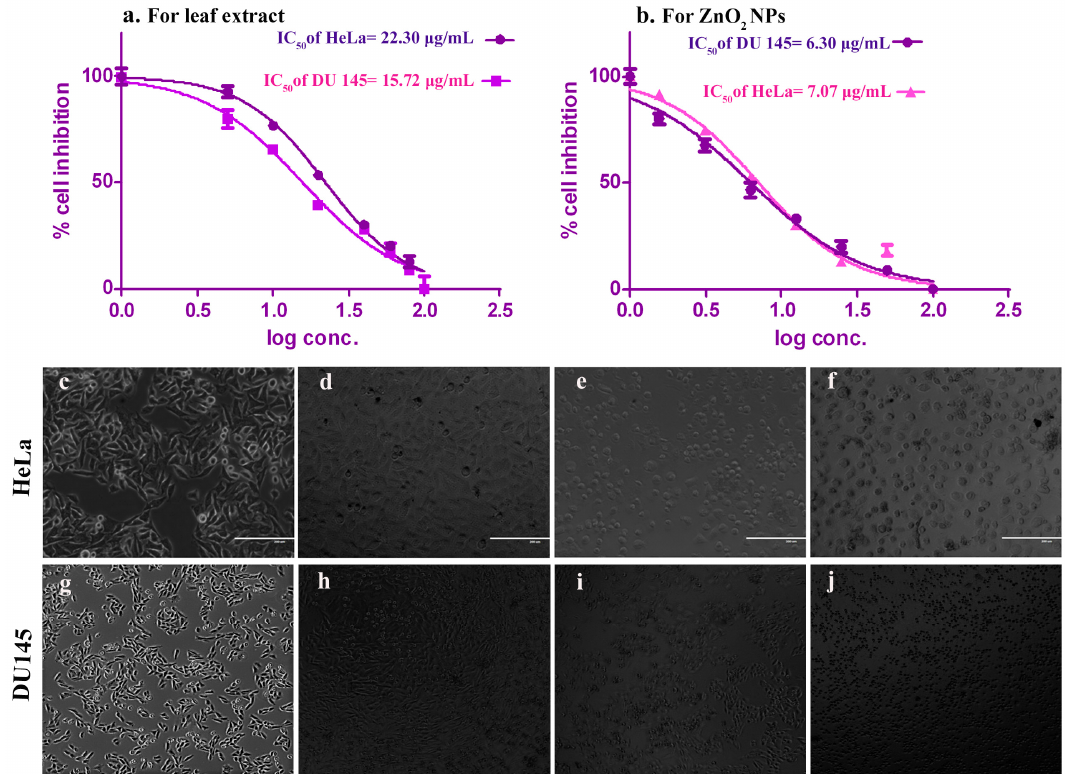
Figure 6. Cytotoxicity measured by MTT assay on HeLa and DU145 cell lines. ( a ) IC 50 value of leaf extract treated cell lines, ( b ) IC 50 value of ZnO NPs treated cell lines. Normal untreated negative control: ( c ) HeLa cell lines and ( g ) DU145 cell lines. Morphological changes due to lower dose of ZnO NPs on: ( d ) HeLa cell lines and ( h ) DU 145 cell lines. Morphological changes due to moderate dose of ZnO NPs on: ( e ) HeLa and ( i ) DU145 cell lines. Morphological changes due to higher dose of ZnO NPs on: ( f ) HeLa and ( j ) DU145 cell lines.